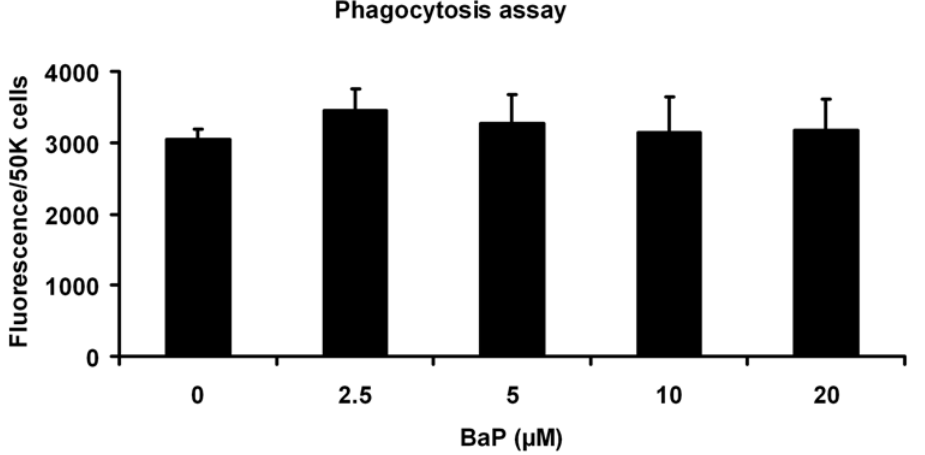
Figure 3. Phagocytic activity of ARPE-19 cells. B(a)P at concentrations in the media of 2.5–20 m M did not change phagocytic activity when cells were exposed to fluorescein labeled bovine photoreceptor outer segments for 3 hr (p . 0.05, n=4).